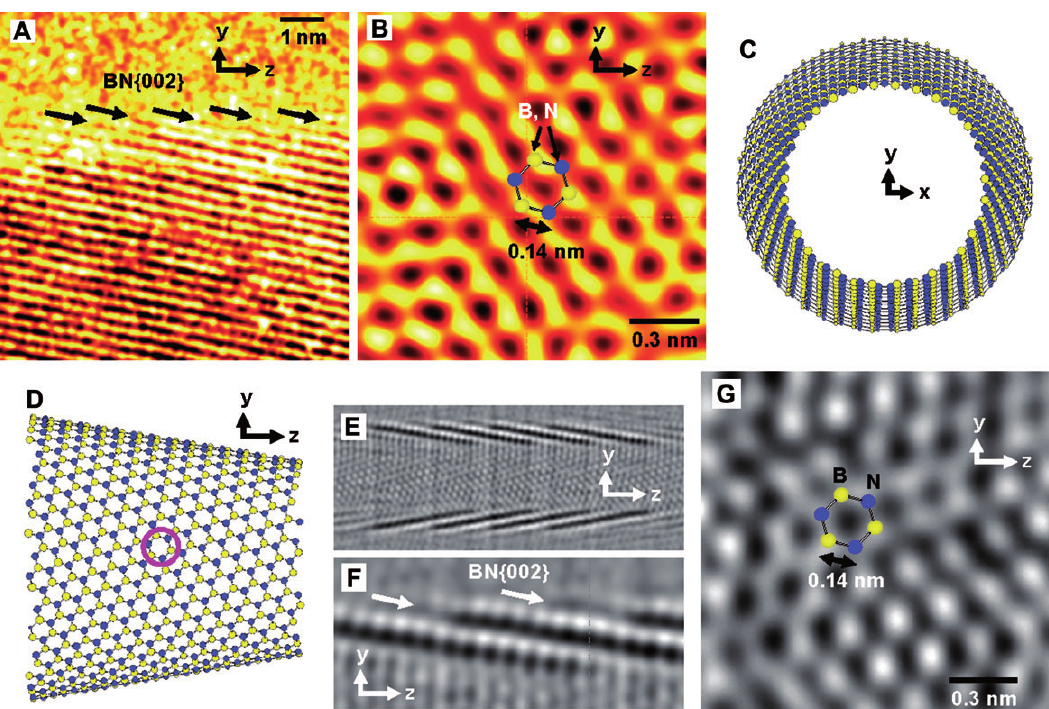
Figure 21 (A) HREM image of edge of BN nanotube wall in Figure 20D. (B) Processed HREM image after Fourier fi ltering of the nanotube center of Figure 20D. Proposed model of BN cup structure projected along (C) the z axis (nanotube axis) and (D) the x axis. (E) Simulated HREM image of four-layered, cup-stacked BN nanotube at defocus values of -40 nm. Enlarged image of (F) edge and (G) center of BN nano- tube in